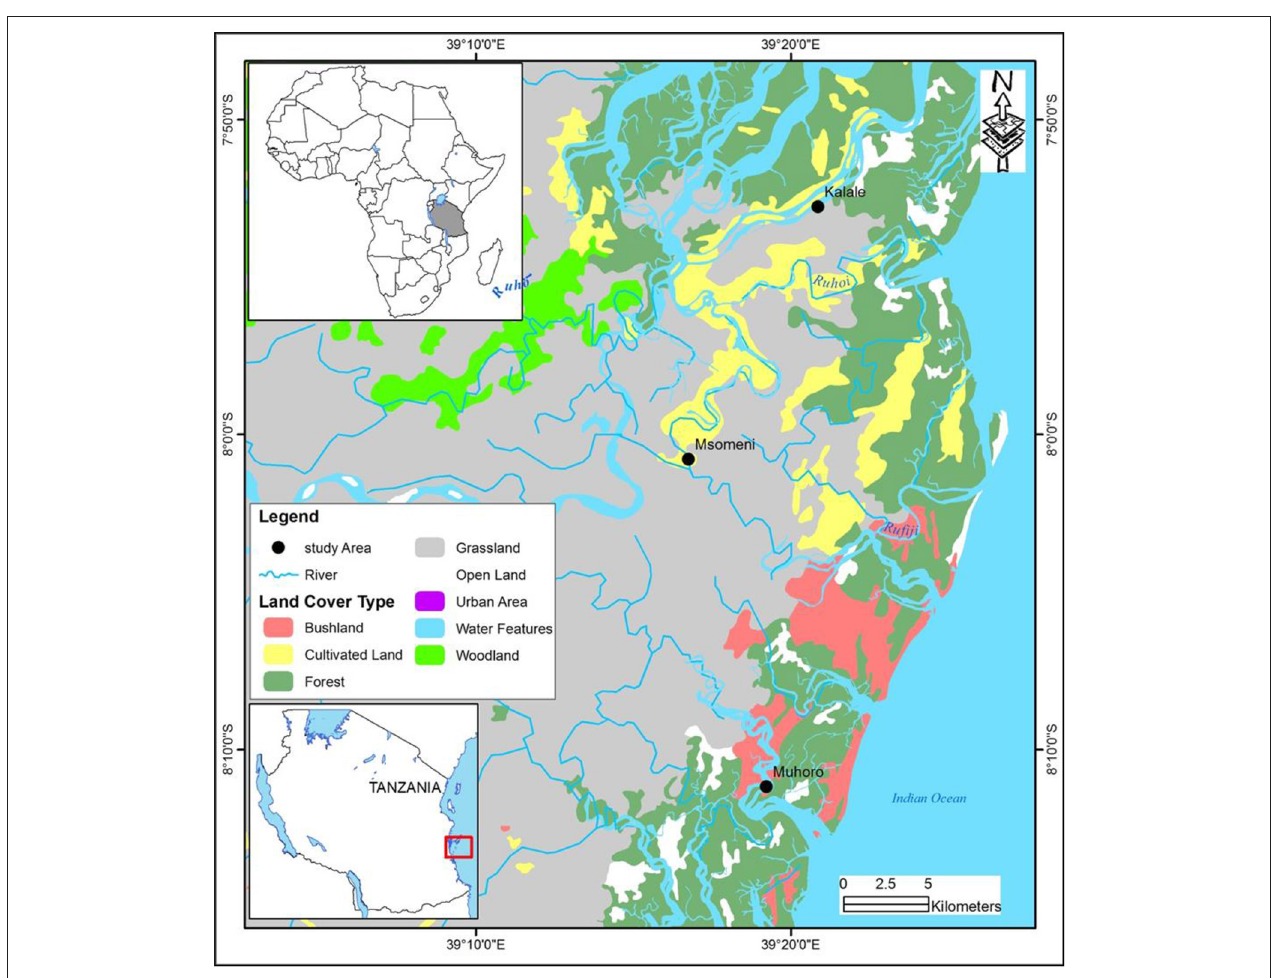
FIGURE 1 | Map of study site in the Rufiji estuary, Tanzania. Three sampling locations are indicated in Muhoro stream (site 1), Msomeni (site 2), and Kalale stream (site